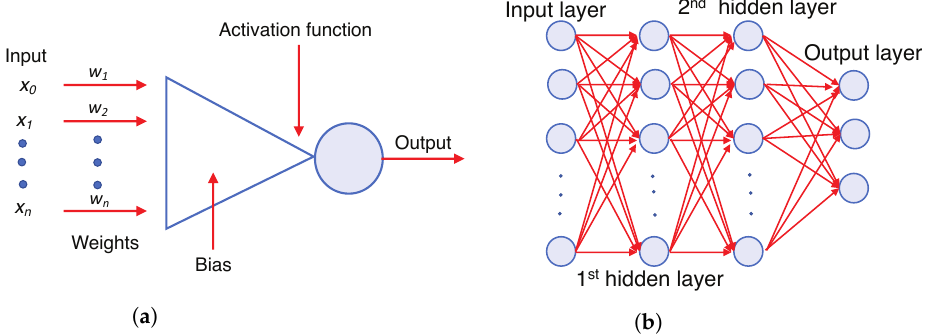
Figure 3. Architecture of artificial neural networks: ( a ) the input values are transformed in a perceptron by the weights, biases, and activation functions, then output values are sent to the next perceptron; ( b ) a multilayered perceptron is composed of several